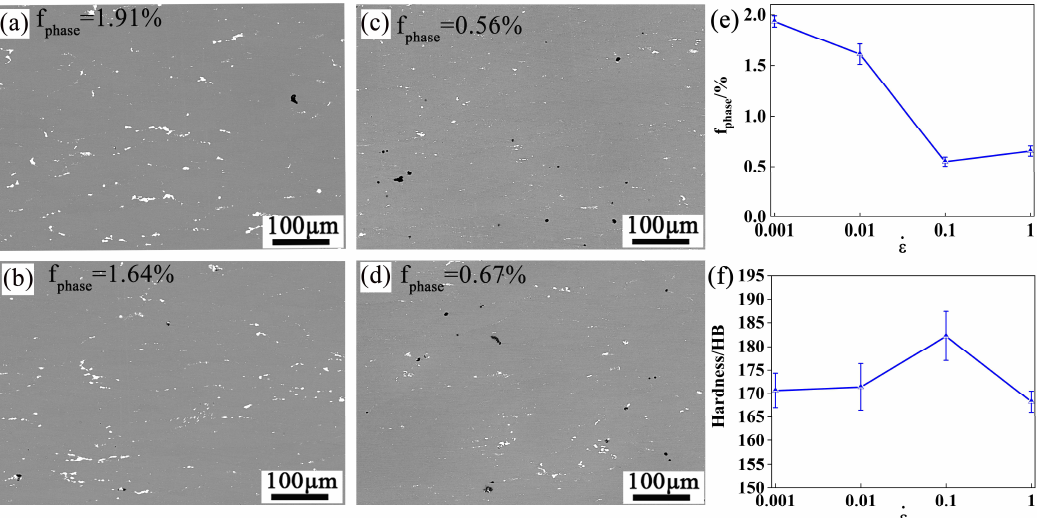
Figure 17. BSE maps of specimens deformed in different conditions after heat treatment: ( a ) 440 ◦ C/0.001 s − 1 , ( b ) 440 ◦ C/0.01 s − 1 , ( c ) 440 ◦ C/0.1 s − 1 , ( d ) 440 ◦ C/1 s − 1 and ( e ) Statistics of fphases%, ( f ) Hardness